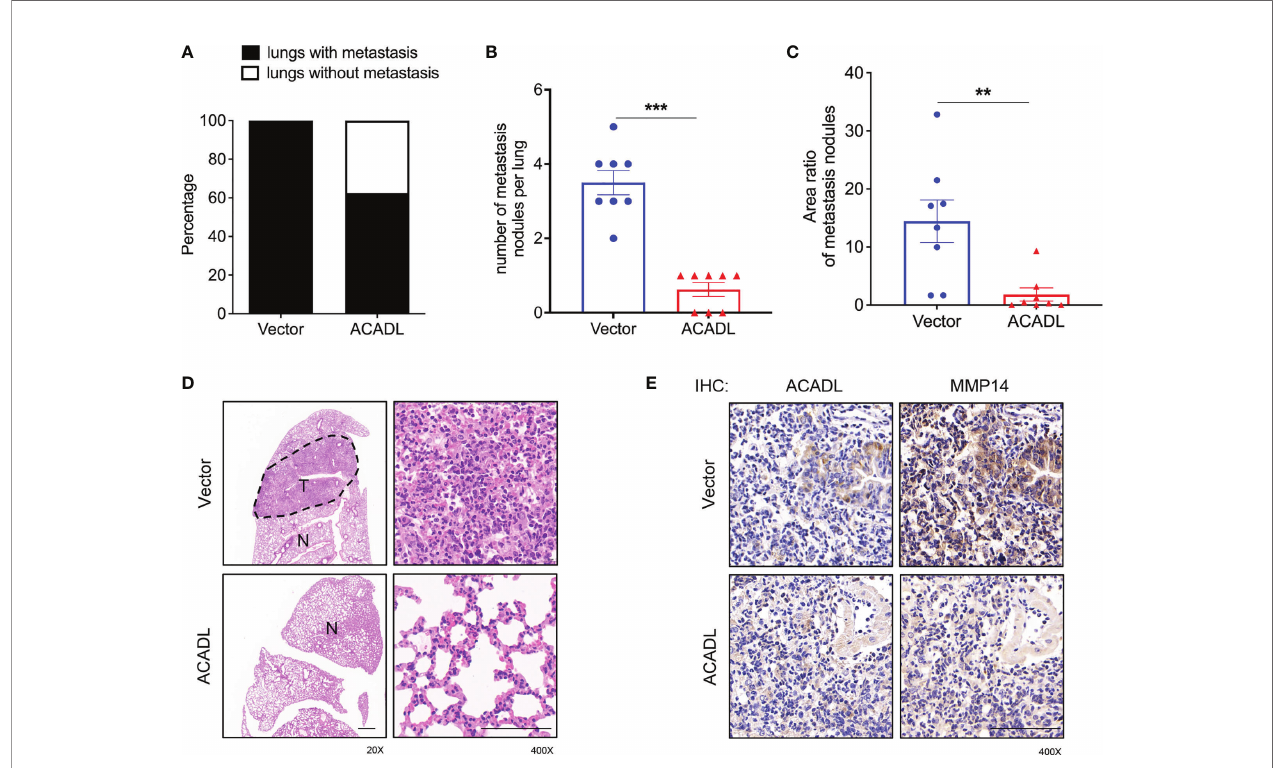
FIGURE 7 | ACADL inhibits lung metastasis of HCC cells in nude mice. MHCC97H cells overexpressing ACADL or those in the control group were injected into nude mice through tail vein to evaluate the effect of ACADL overexpression on the in vivo metastasis of MHCC97H cells. (A) Ratio of metastatic models. (B) The number of metastatic nodules in lungs from overexpressing ACADL group or those in the control group. (C) Area of metastatic nodules in the lungs. (D) Representative H&E staining images of lung tissues from nude mice in different groups. (E) IHC staining of ACADL and MMP14 was carried out to identify the lung metastatic nodules formed by MHCC97H cells. **P < 0.01, and ***P < 0.001 compared with